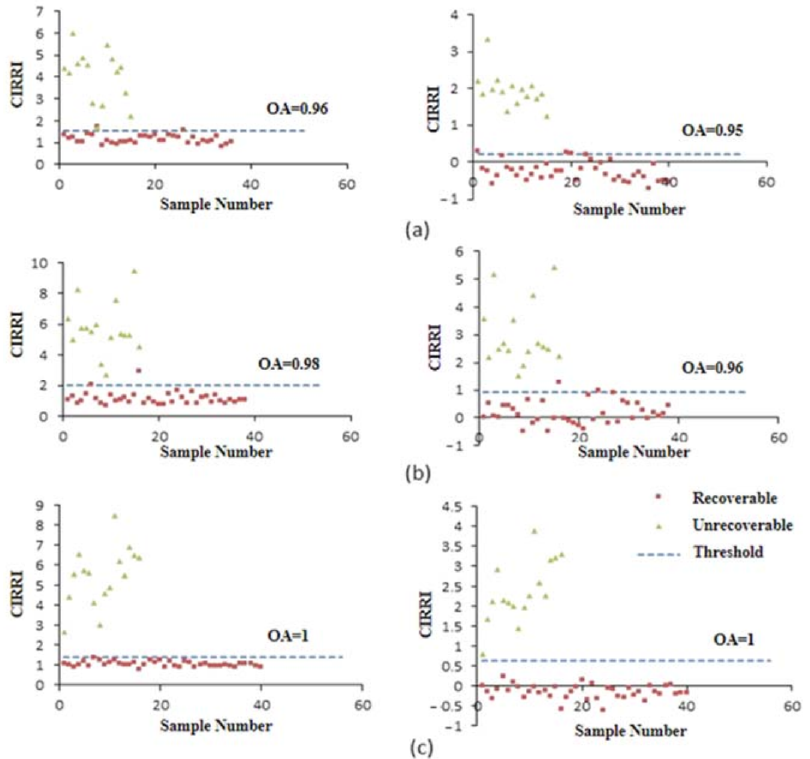
Figure 7. Differentiation between recoverable and unrecoverable corn plants based on CIRRI and CIRNI at 1 WAT ( a ), 2 WAT, ( b ) and 3 WAT ( c ).